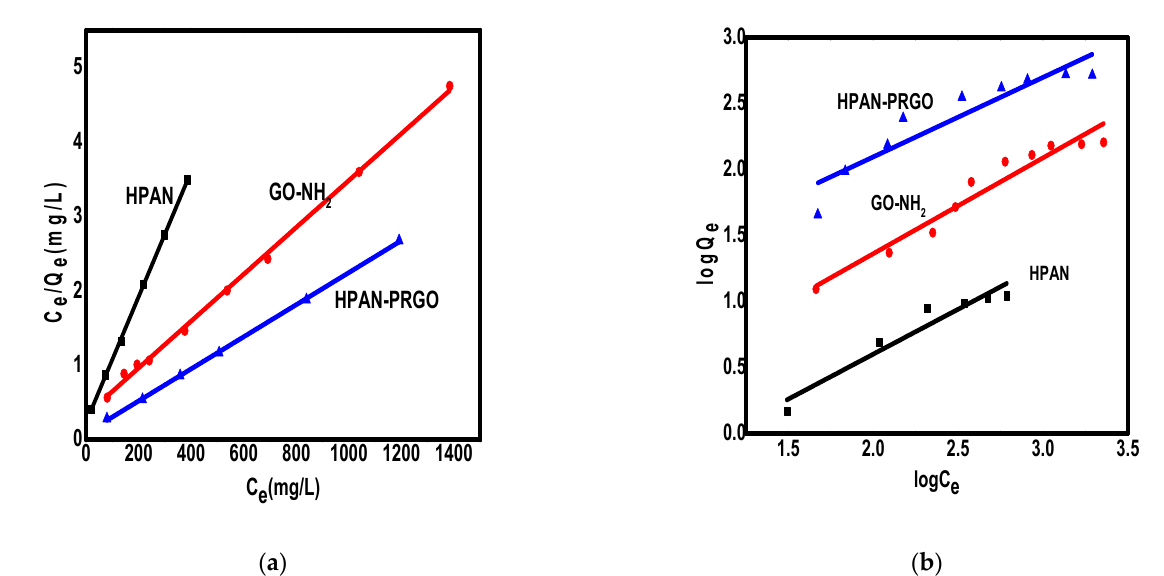
Figure 7. ( a ) Langmuir linear fitted curve and ( b ) Freundlich linear fitted curve for the removal of Sm 3+ ions over HPAN- PRGO, GO-NH 2 , and HPAN.